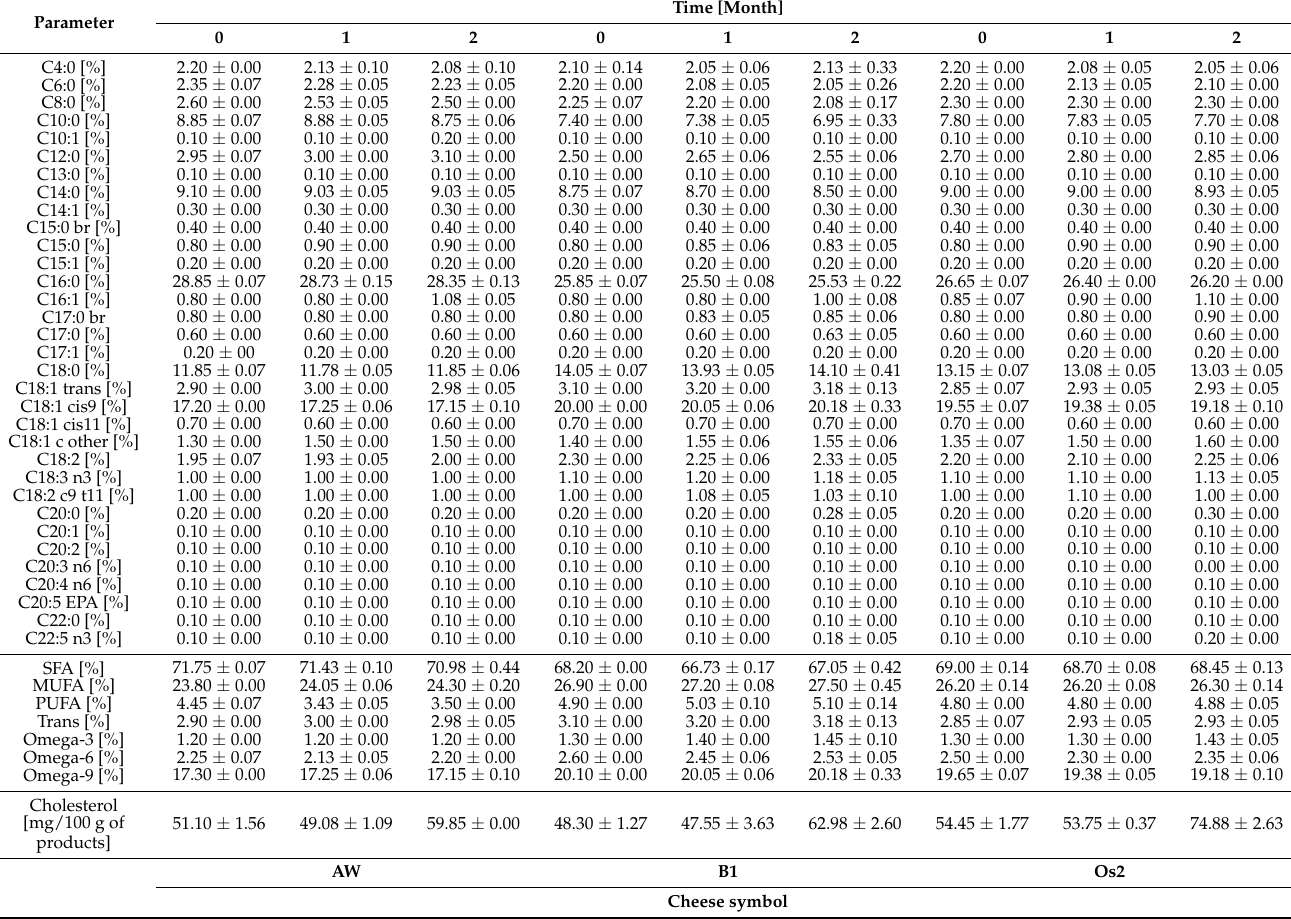
Table A1. Fatty acid composition and cholesterol content in goat’s acid-rennet cheeses after produc- tion and after 1 and 2 months of storage (n = 4).